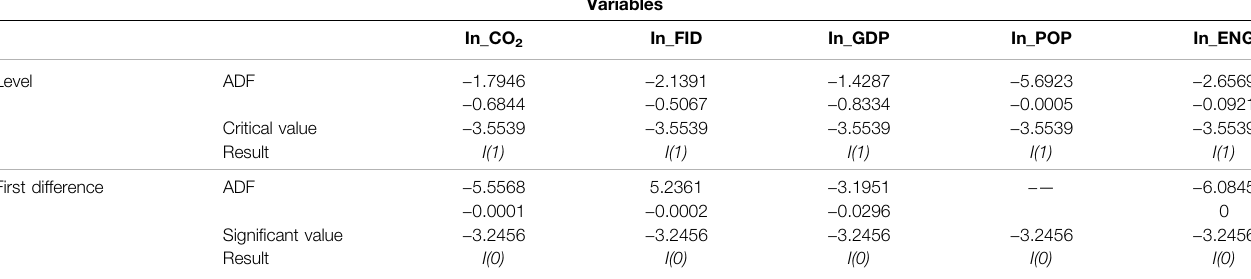
TABLE 2 | Unit root test and critical value results for